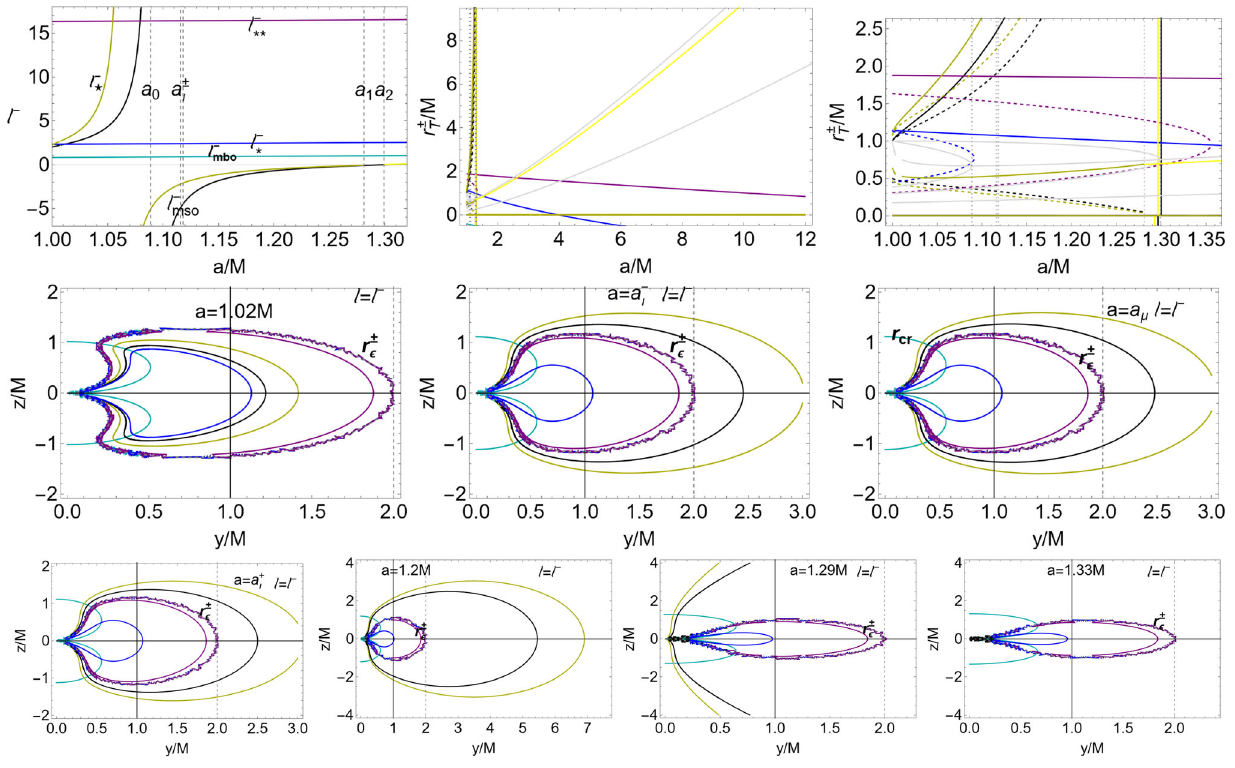
Fig. 20 Analysis of tori with fluids specific angular momentum (cid:6) = closeupviewofthecenterpanel:inversionradius r ± (cid:2) ondifferentplanes (cid:6) − , (cid:6) − = (cid:6) + < 0 and flows inversion points. For (cid:6) − > 0 inver- σ ≡ sin 2 θ , on the equatorial plane σ = 1 (plain curves) and σ = 0 . 5 sion points are only for space-like particles with ( E < 0 , L < 0 ) (dashed curves) and specific angular momenta according to the colors in the conditions of Sec. (C). Here most general solutions r ± (cid:2) are notation of the left panel. Remaining panels show the inversion radius shown, while further constraints are in Sect. 3.2. Spins a ± ι , are defined r ± (cid:2) on the plane ( y / M , z / M ) , where σ = sin 2 θ = y 2 /( z 2 + y 2 ) and (cid:6) in Eq. (11). There is a μ ≡ a + ι − ( a + ι − a − ι )/ 2, and ((cid:6) − ∗ ,(cid:6) − ∗∗ ) are r = z 2 + y 2 , for different fluid specific angular momenta (cid:6) , accord- (cid:6) − ≡ (cid:6) − + 1 . 5, (cid:6) − ≡ (cid:6) − + 15 . 5, with (cid:6) − ≡ (cid:6) − ( r − ) , where ∗ ∗∗ (cid:22) (cid:22) ing to the notation signed on the upper line left panel. Tori models and mbo mbo − )/ 9,for a > a ≡ ¯ r − − ( ¯ r − − r − )/ 2 r − (cid:22) ≡ ¯ r − mso − ( ¯ r − mso − r − accretion flows inversion points are shown in Figs. 10 and 19. Note (cid:22) 1 ,and r mso mso mbo 0 for a ∈] M , a 1 [ . ( mso is for marginally stable orbit and mbo is for the inversion radius location with respect to the ergosurface r ± (cid:11) . Fig- marginally bounded orbit). See also Fig. 11 and 12. Upper line left ure13 show the analysis for fluids with momenta (cid:6) = (cid:6) + < 0. Radius panel: the fluid specific angular momentum (cid:6) − as function of a / M . r cr = r + (cid:2) = r − (cid:2) is defined in Eq. (10) Radii r ± (cid:11) are the outer and inner ergosurfaces. Upper line right panel is a